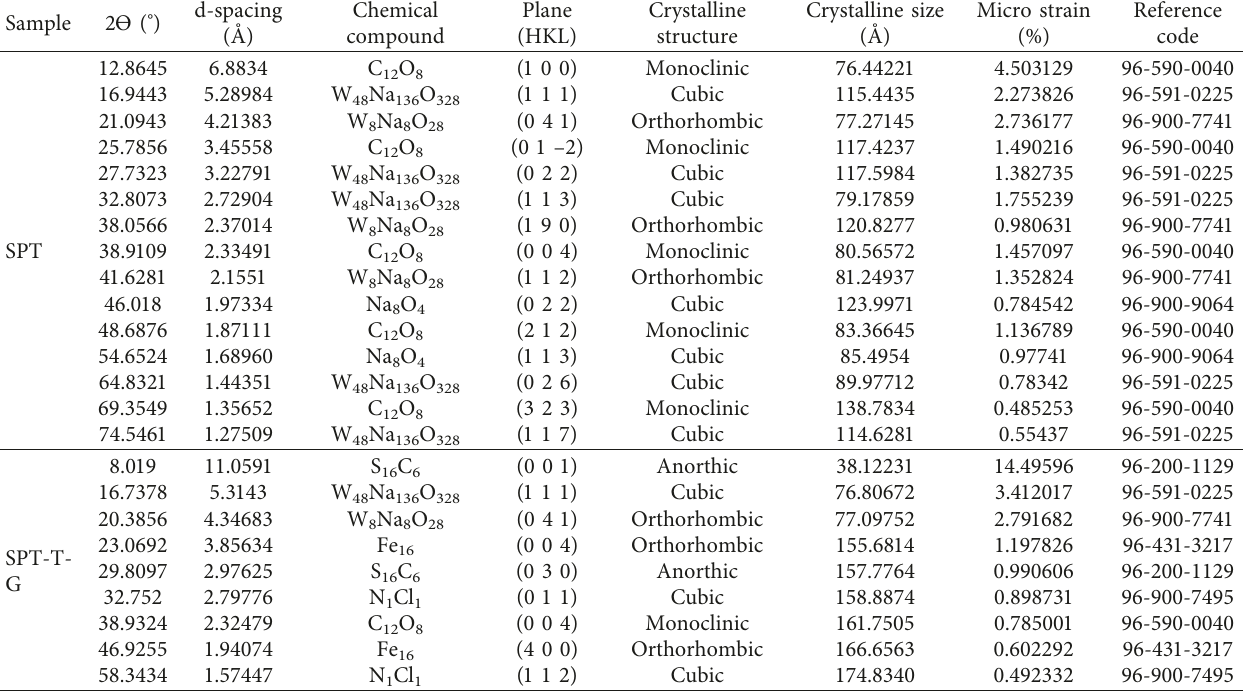
Table 1: Data obtained from the XRD analysis for SPT and SPT-T-G nanostructures.